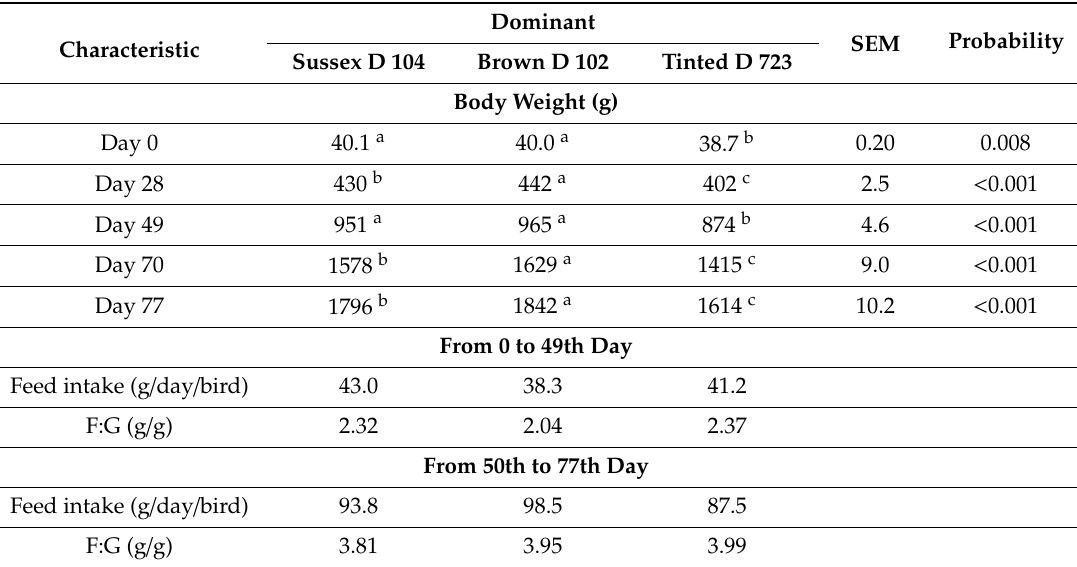
Table 3. Performance traits of Dominant